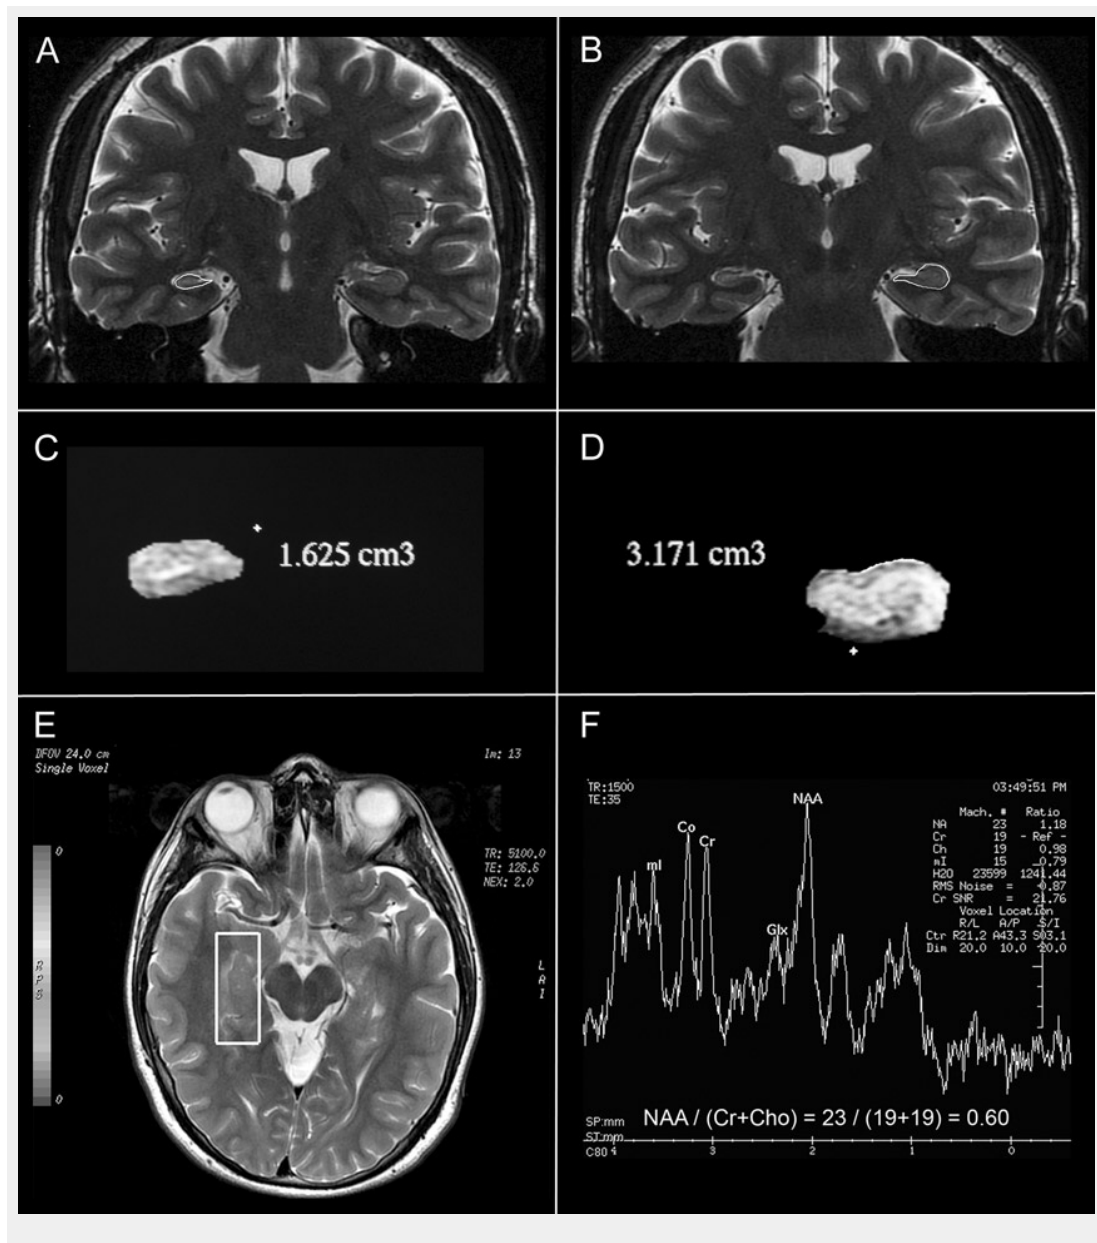
A and B coronal T2-weighted MRI showing the countours of hippocampi as part of the 3D volumetry. C and D, 3D reconstruction of the hippocampus showing a decreased-volume hippocampus and a superior normal limits hippocampus. E, axial-oblique plane showing the location and size of the voxel. F, MR spectrum in a case with MTS depicts an abnormal spectrum with decreased NAA/(Cr+Cho) ratio and increase in the